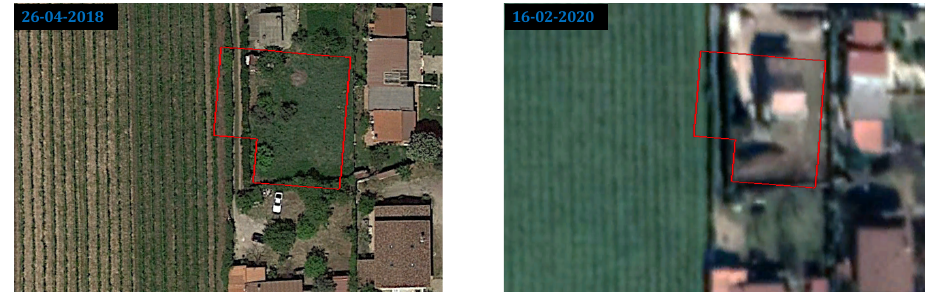
Figure 9. Scene comparison of the Rome Fiumicino airport area. The image on the left has very-high resolution, while the image on the right is acquired by the Sentinel-2 satellite mission. The algorithm correctly detects a new house built in the scene.